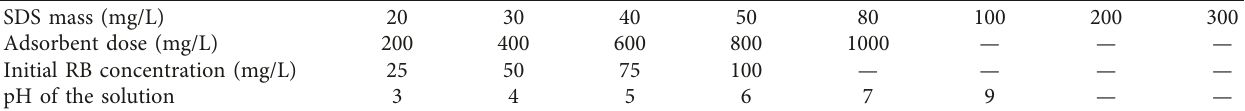
Table 1: The variable values of batch adsorption